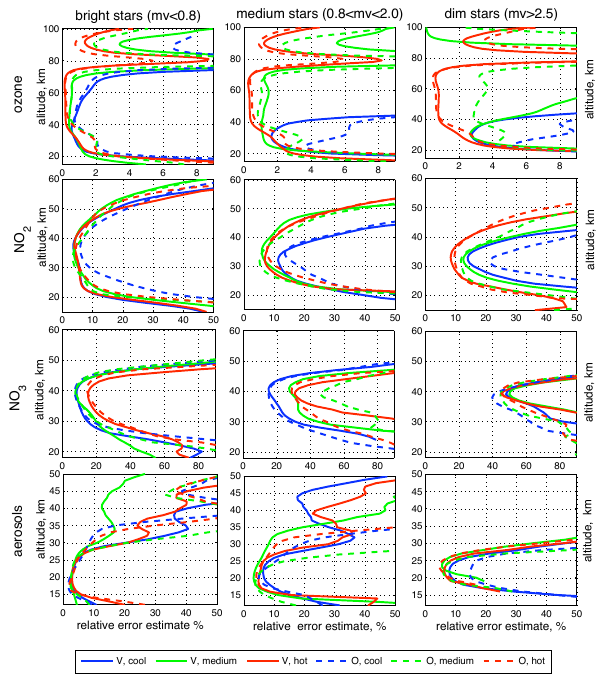
Fig. 12. GOMOS error estimates of O 3 (top row), NO 2 (second row), NO 3 (third row) and aerosols (bottom row) for representative cases: bright star (first column), typ- ical star (middle column) and dim star (last column). The dashed lines correspond to oblique occultations and the solid lines to occultations in orbital plane. Stellar temper- ature is indicated with the line colour: hot stars (red), medium stars (green) and cool stars (blue). These values correspond to the upcoming data processing (IPF Version 6.0).